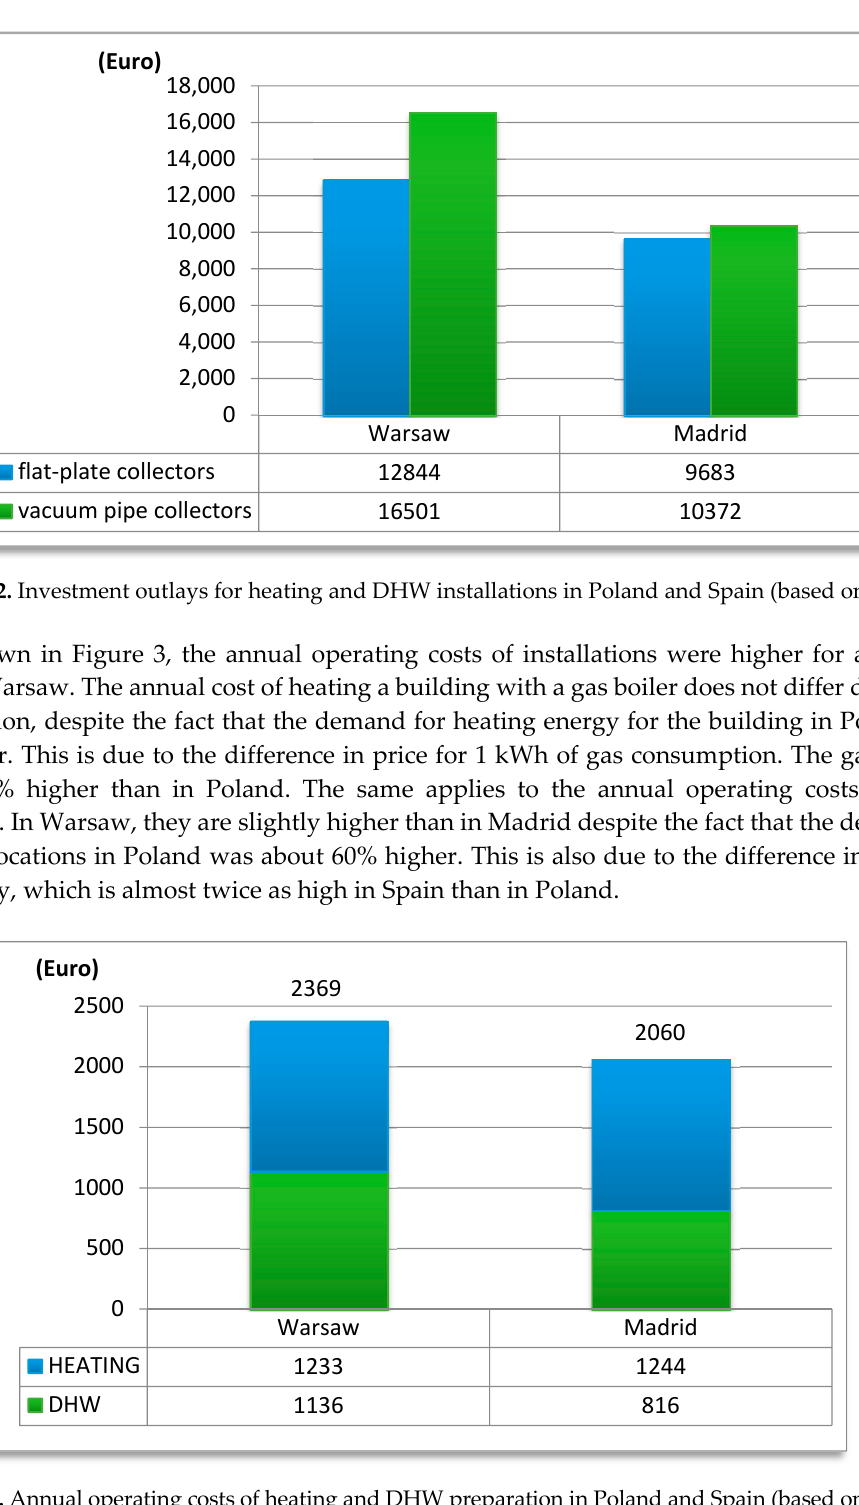
Figure 3. Annual operating costs of heating and DHW preparation in Poland and Spain (based on